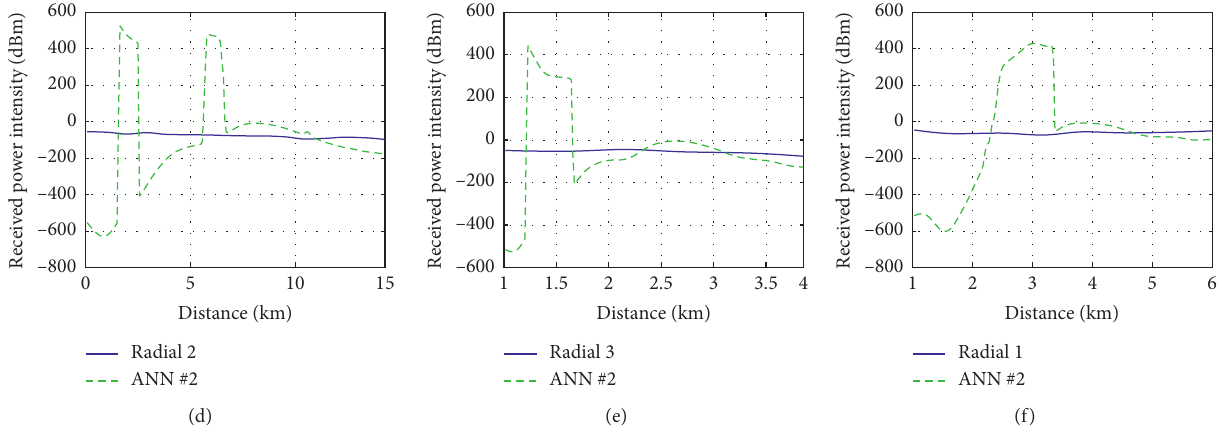
Figure 10: Product combination for original radial 2 (a); original radial 3 (b); original radial 1 (c); interpolated radial 2 (d); interpolated radial 3 (e);and interpolated radial 1 (f).